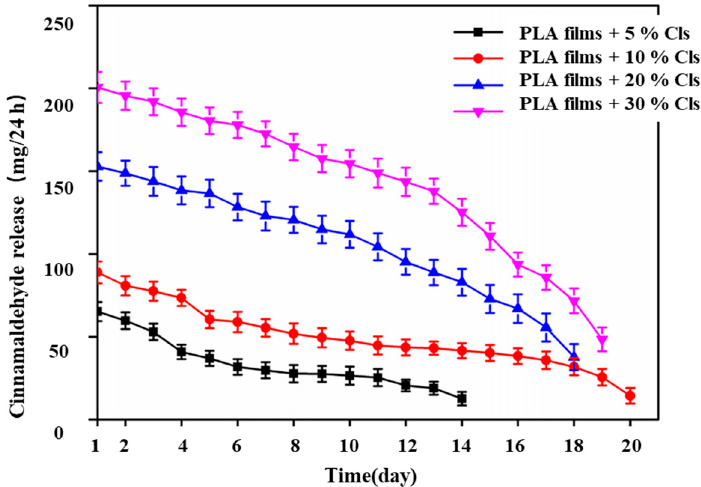
Figure 3. Release curves of antibacterial PLA antibacterial films with 5, 10, 20, and 30% of Cis. Reprinted with permission from Ref. [66], published by Elsevier, 2022.